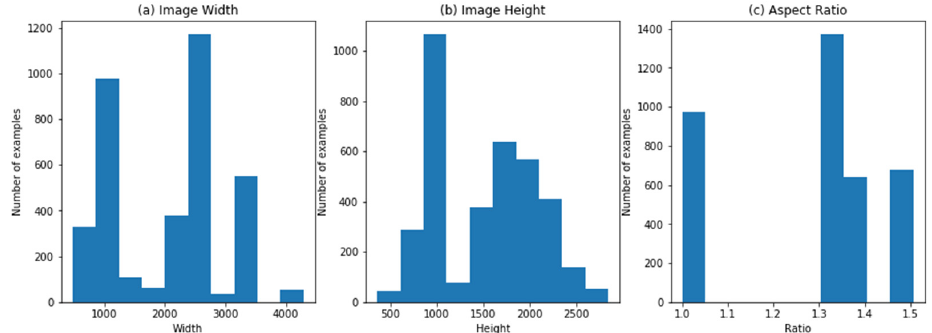
Figure 6. ( a ) Image width; ( b ) image height; ( c ) image aspect ratio.